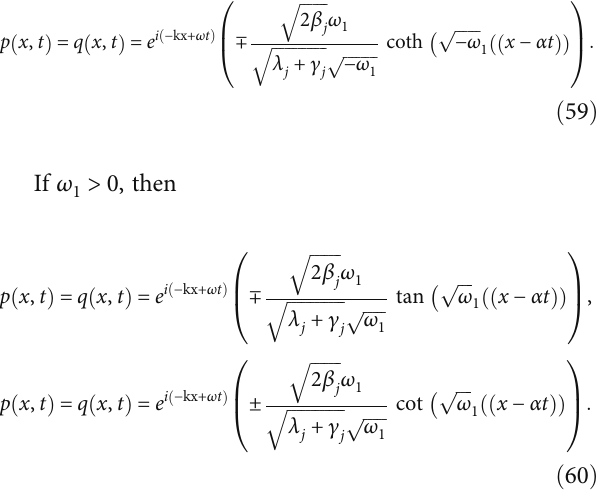
: 4, β : 3, γ : 4, k = 0 : 2, α = 0 : 3, ω j = 0 j = 0 j = 0